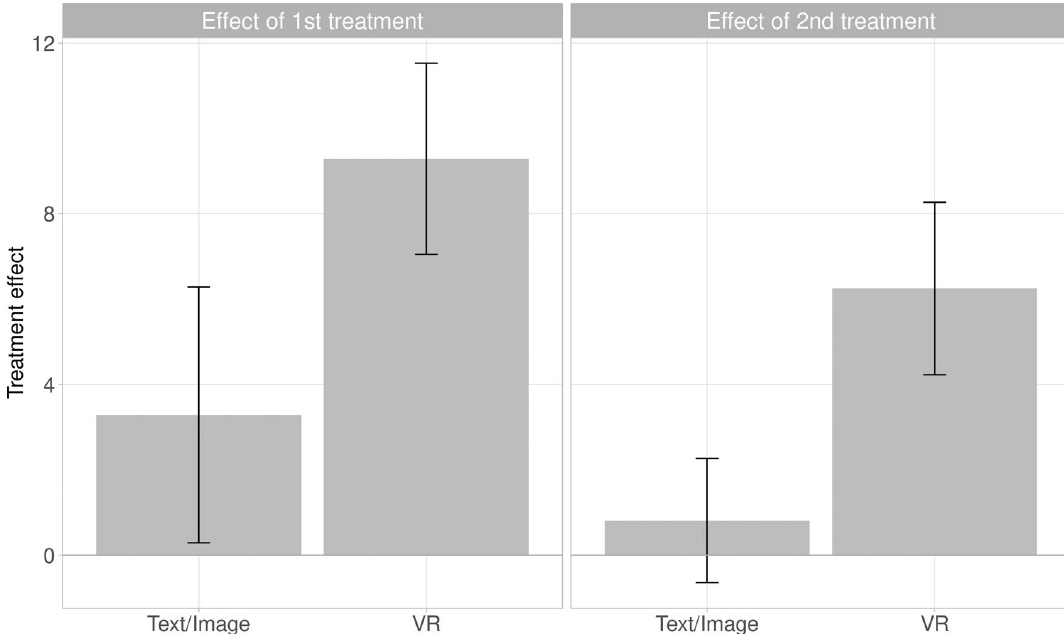
Figure 3. Average effect on vaccination intention of first treatment ( n = 195, left panel) and second treatment ( n = 189, right panel), leaving out participants with maximum pre-treatment vaccination intention. Error bars are 95%